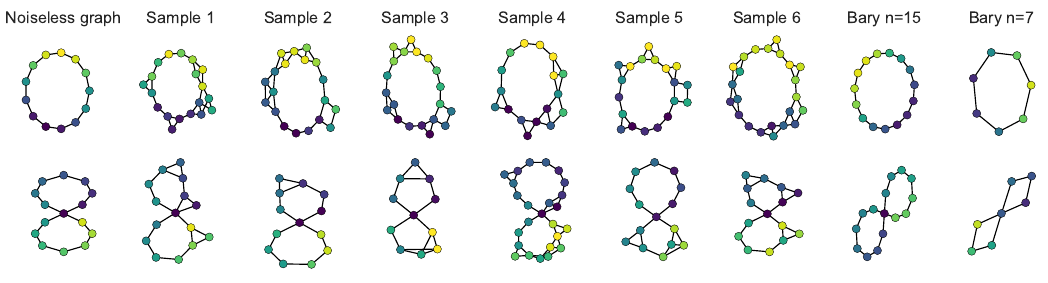
Figure 13. Illustration of FGW graph barycenter. The first column illustrates the original settings with the noiseless graphs, and columns 2 to 7 are noisy samples that constitute the datasets. Columns 8 and 9 show the barycenters for each setting, with different number of nodes. Blue nodes indicates a feature value close to − 1, yellow nodes close to